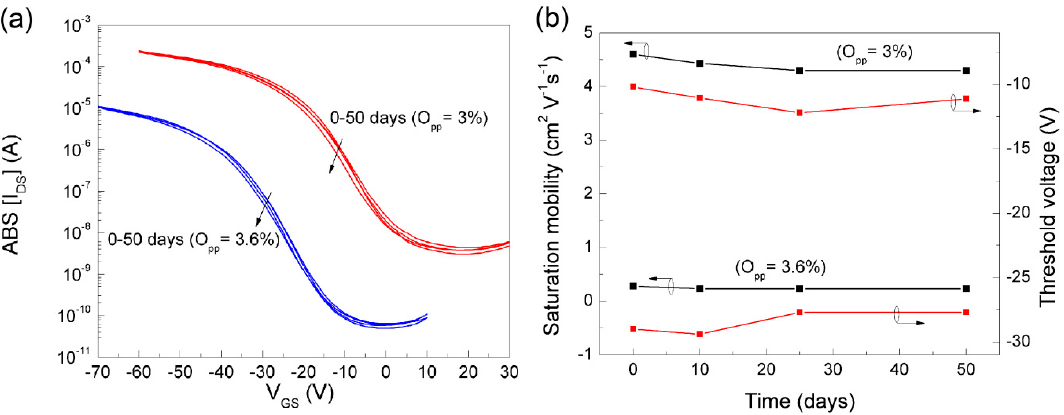
Figure 8. Transfer characteristics of SnO x p-channel TFT measured at different days after device fabrication ( a ) and corresponding variations in saturation mobility and threshold voltage ( b ).